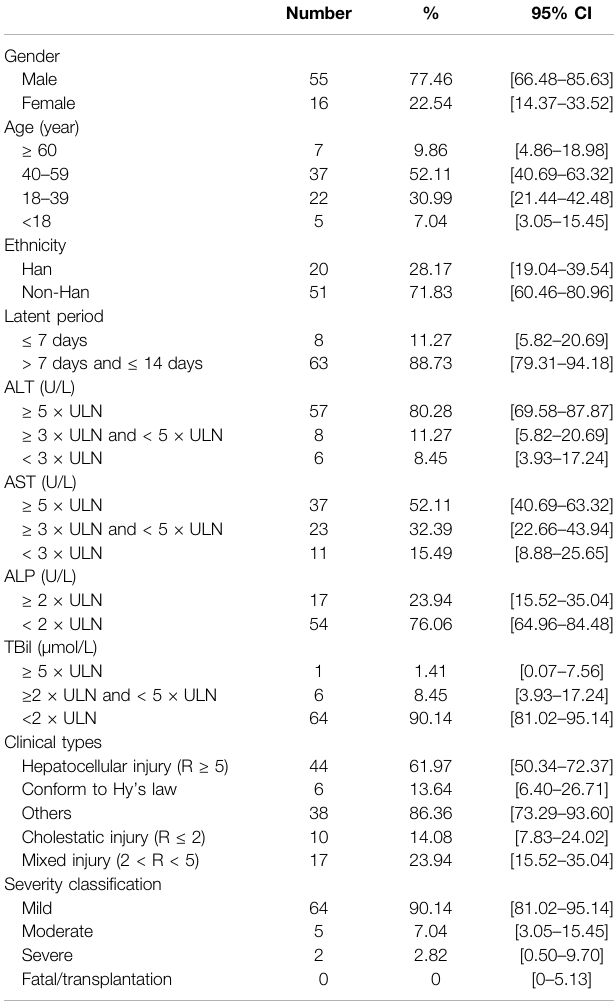
TABLE 2 | Demographic and clinical features of 71 brucellosis-associated DILI hospitalized in Shawan County People ’ s Hospital from January 2015